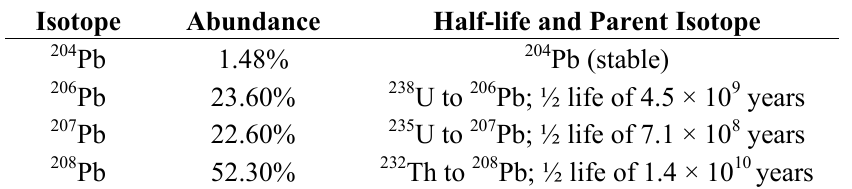
Table 1. Selected properties of Pb isotopes used in environmental